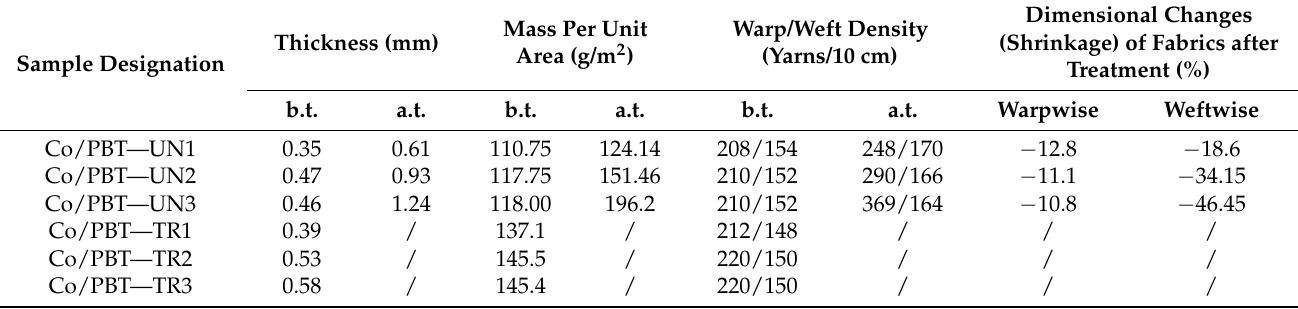
Table A9. Physical properties of samples before (b.t.) and after (a.t.)